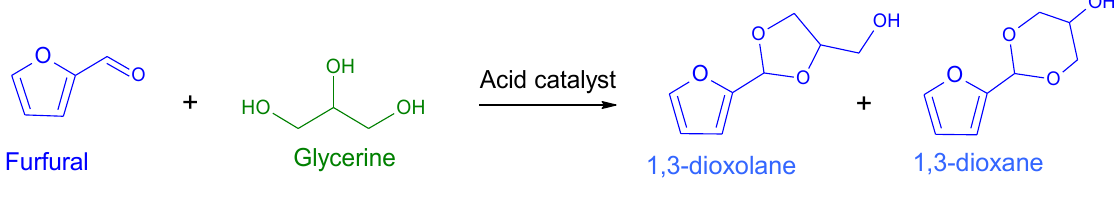
Figure 1: Scheme of the acetalization of glycerol with